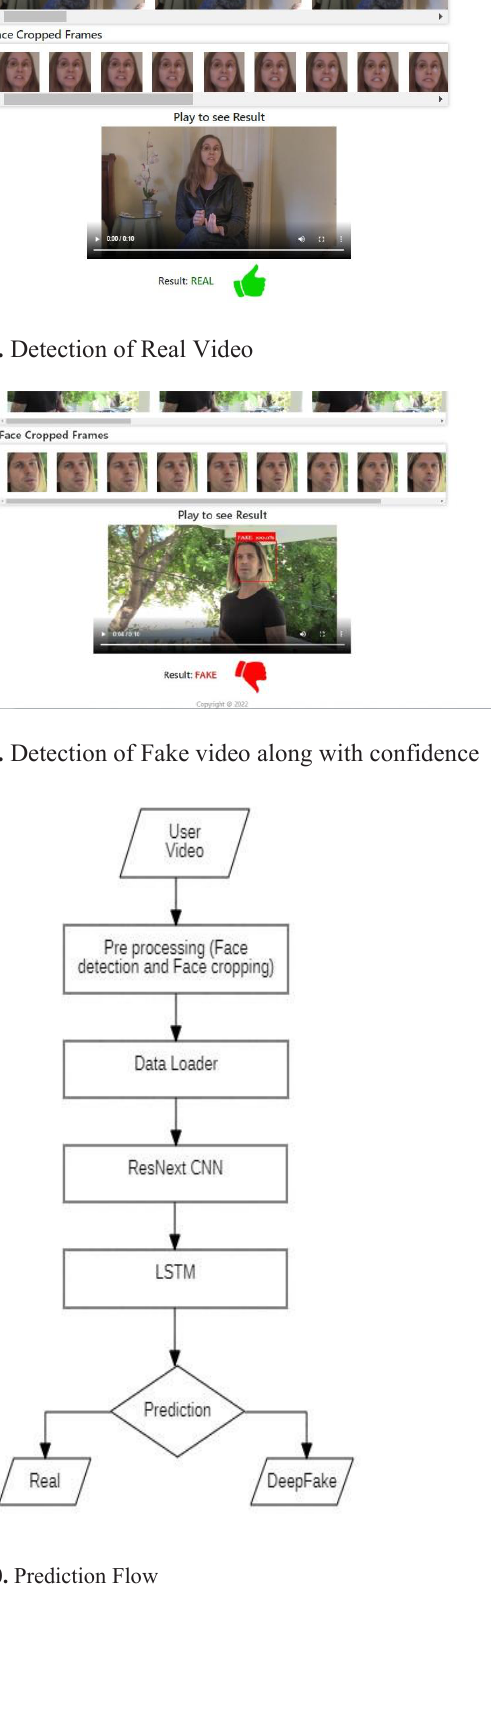
Fig. 7. GUI for video uploading